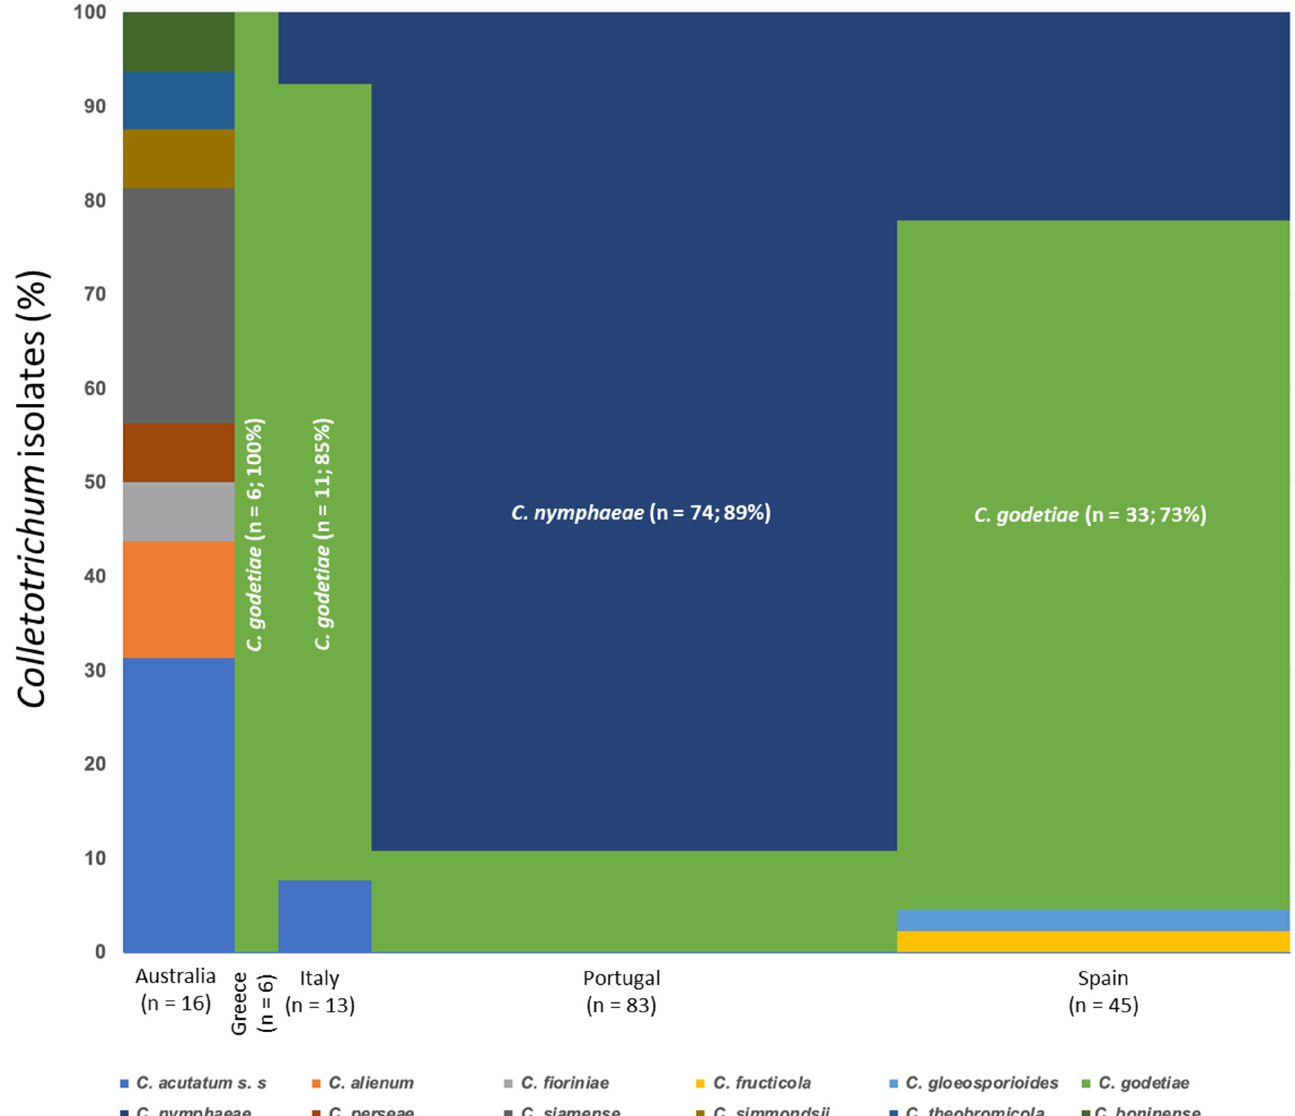
Figure 6. Mosaic Plot representing the relative percentage of twelve Colletotrichum species in the five countries where six or more fungal isolates were studied. n = number of Colletotrichum isolates analyzed.